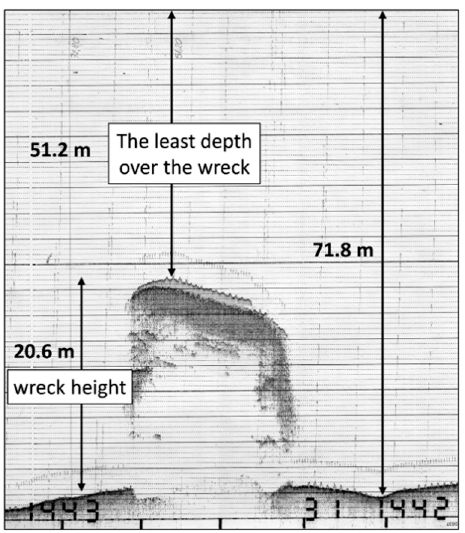
Figure 7. Single-beam echosounder data (echogram) showing the least depth over the wreck, surrounding depth, and the height of the object.